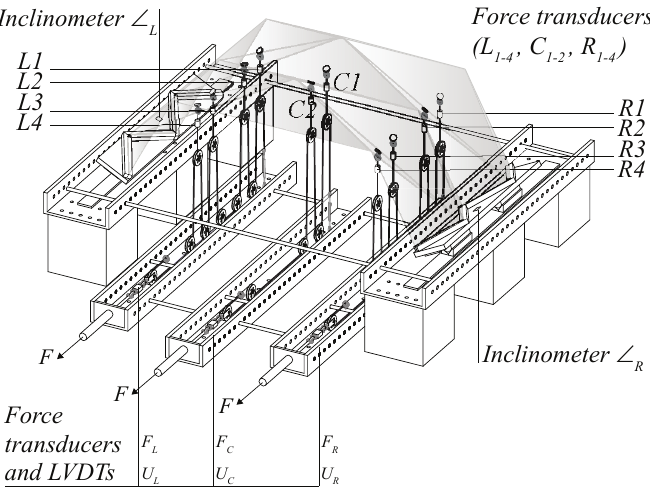
Figure 3. Test setup with marked measurement instrumentation.